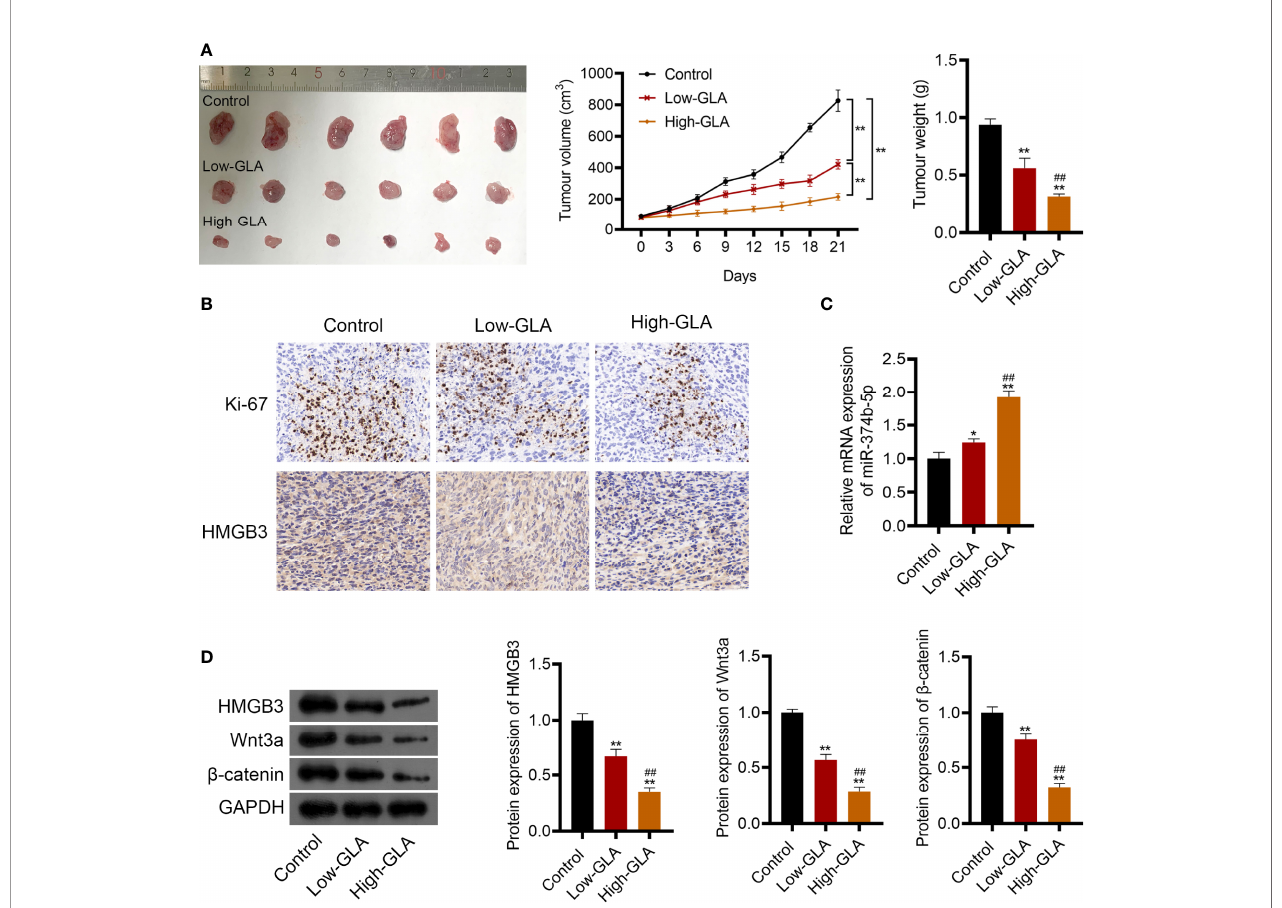
FIGURE 8 | GLA restrained the EOC tumor growth via affecting miR-374b-5p/HMGB3/Wnt- b -catenin pathway axis. BALB/c nude mice were subcutaneously injected SKOV3 cells and treated with low- or high-dose GLA. (A) Tumor volume and weight were recorded. (B) The expression of Ki-67 (a cell proliferation marker) and HMGB3 in tumor tissues was identi fi ed by immunohistochemistry. Scale bar = 20 µm. (C) The expression of miR-374b-5p in tumor tissues. (D) The protein levels of HMGB3, Wnt3a, and b -catenin in tumor tissues. *P <0.05 and **P <0.01 vs. control; ##P <0.01 vs. the low-